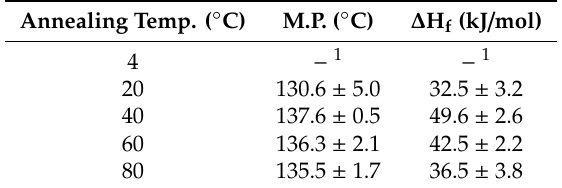
Table 2. Temperature-dependent change in the thermal properties of the VRC-TAR system after 3-day annealing.